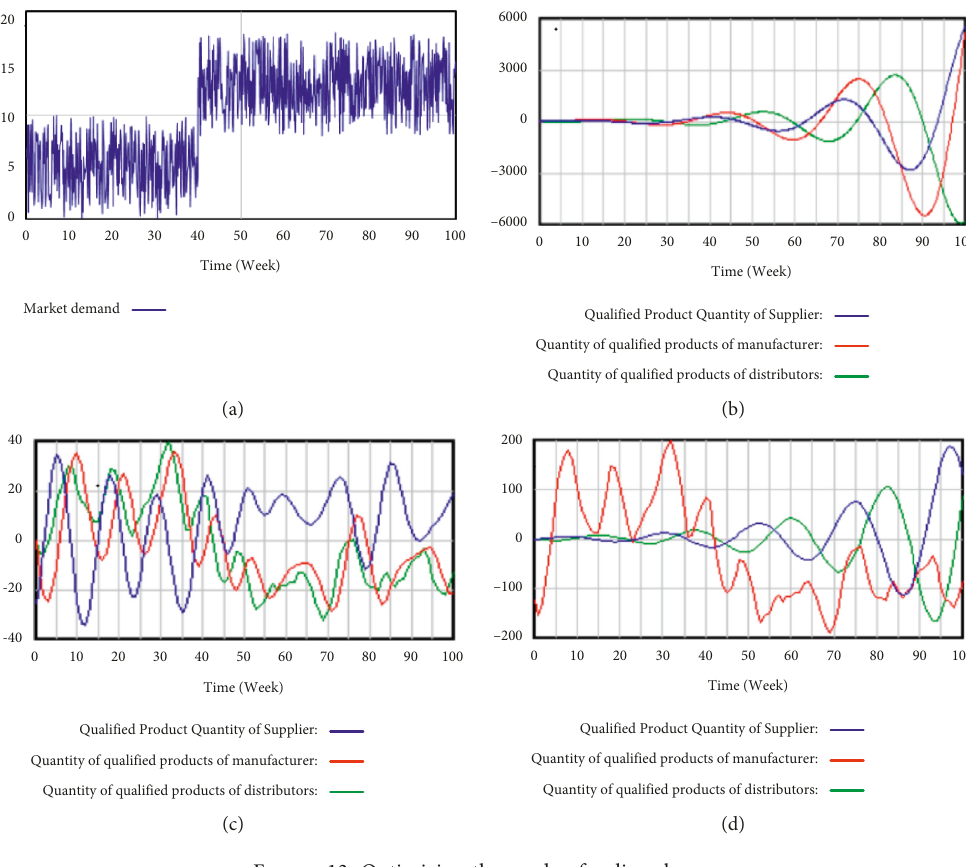
Figure 13: Optimizing the mode of policy